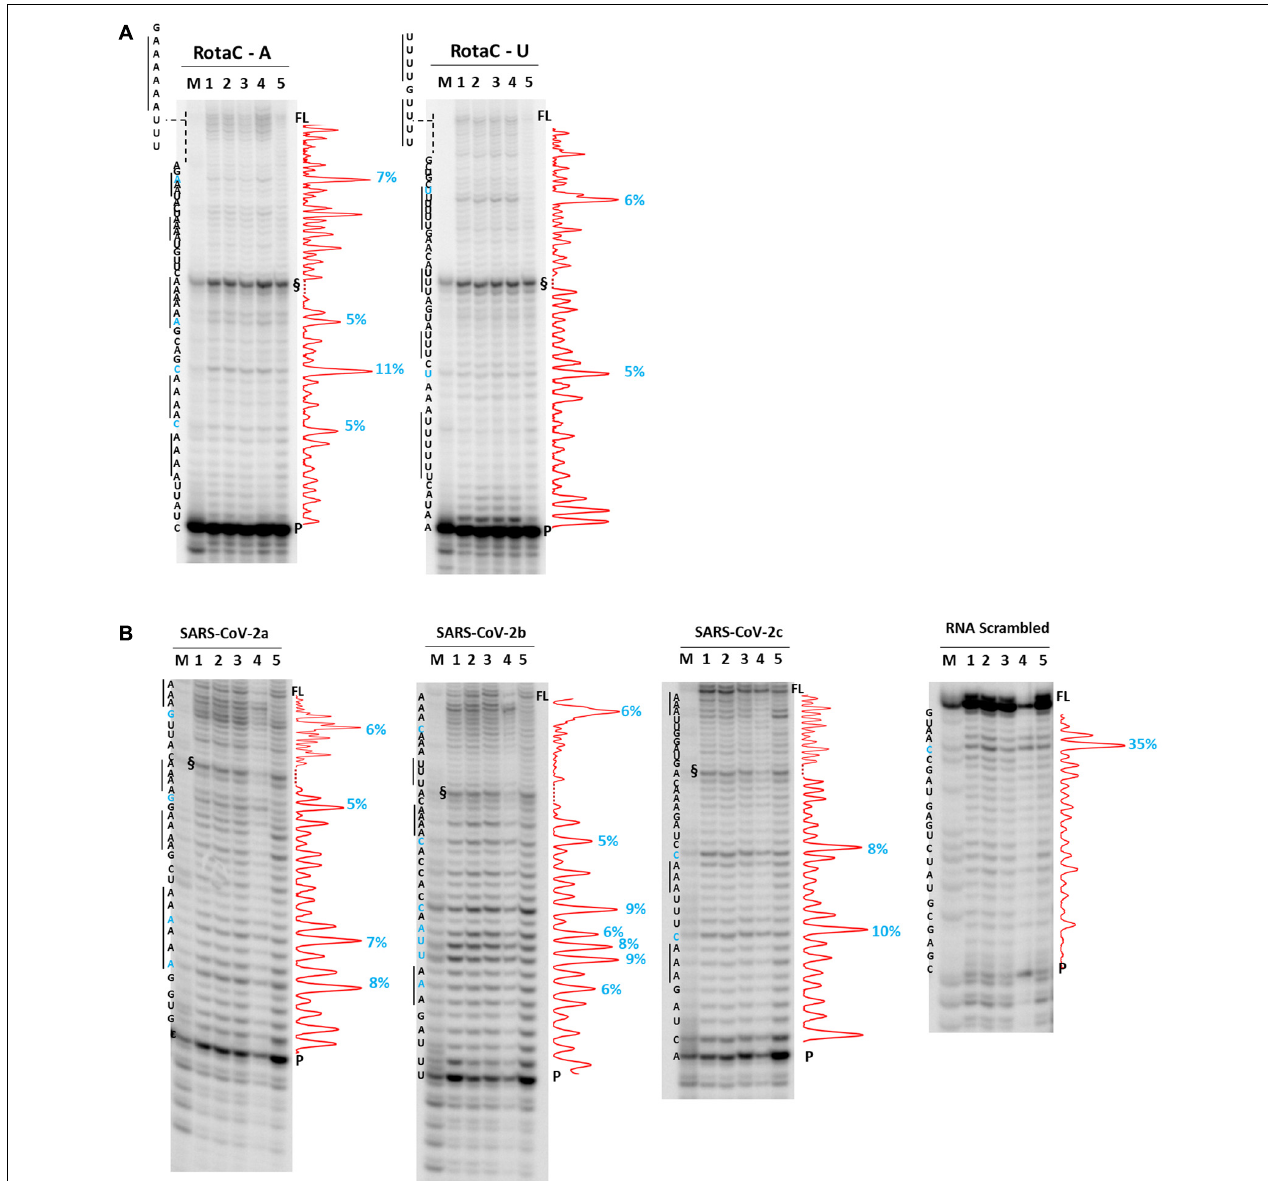
FIGURE 9 | RT stop assay on RotaC (A) and SARS-CoV-2 (B) sequences. Analysis was performed in the absence (lane 5) or presence of 100 mM different salt types, such as KCl (1), NaCl (2), LiCl (3), and NaF (4). M indicates a sequence marker lane, obtained by the Maxam and Gilbert sequencing protocol; P indicates the unreacted labeled primer; FL indicates the full-length elongation product; § indicates primer dimer band and was excluded from quantitation (dotted line). Red densitograms show stop bands quantification. Percentages of peaks ( ≥ 5%) are reported in blue, along with the corresponding nucleotide. Elongation was performed at 44 ◦